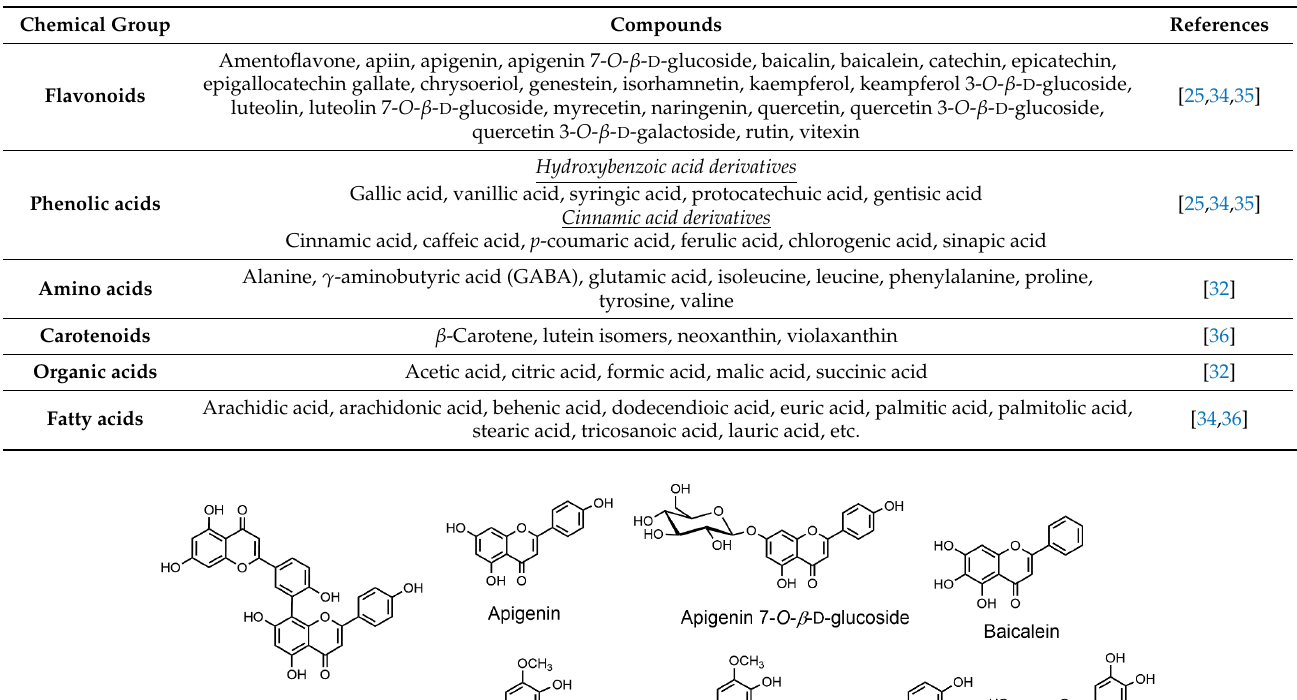
Table 1. Bioactive chemical constituents of leaves of Urtica dioica .